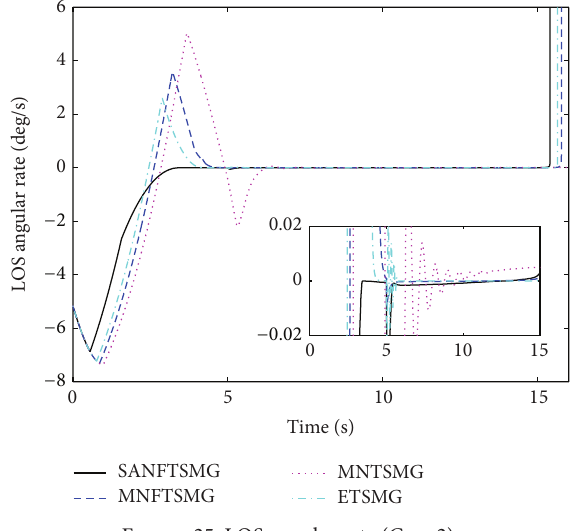
Figure 25: LOS angular rate (Case 2).